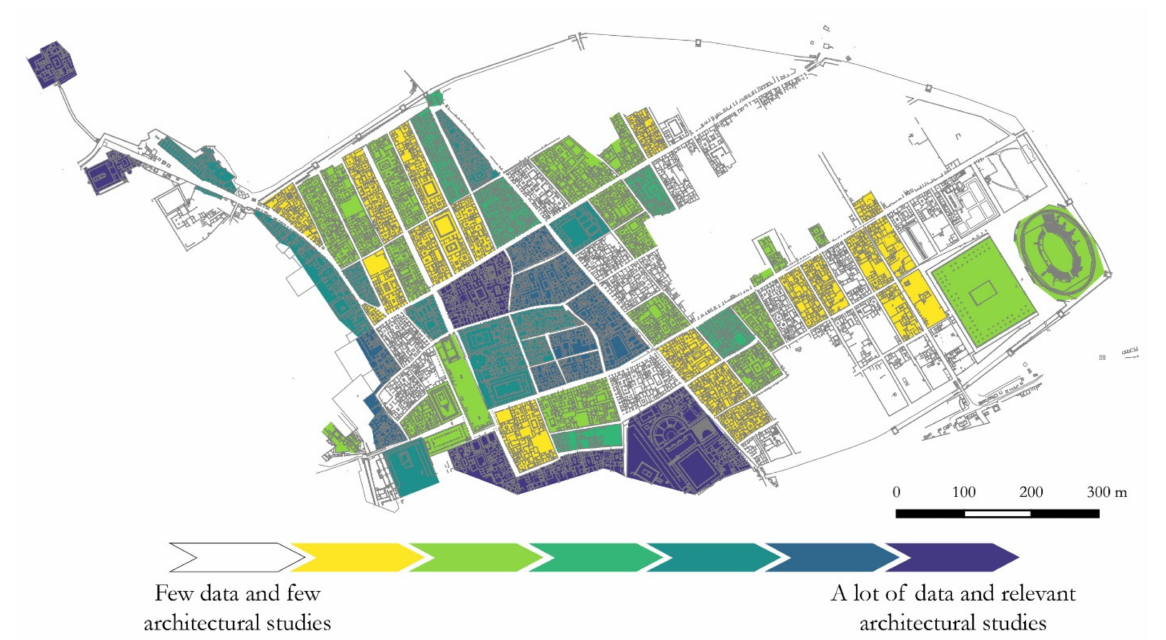
Figure 10. Assessment of damage and post-seismic repairs based on recent scientific literature